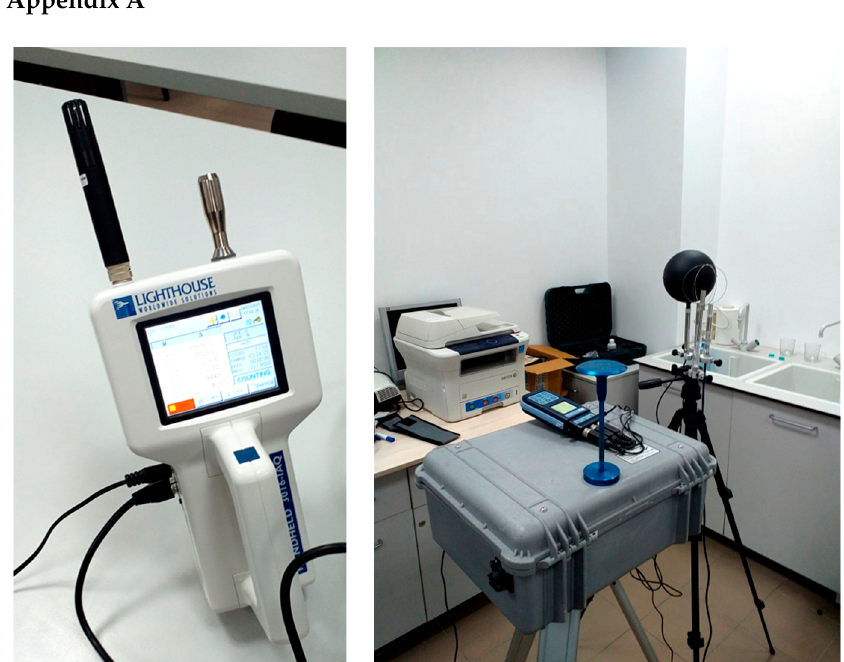
Figure A1. Instrumentation used in the current study (particle counter, PM monitor, and thermal microclimate equipment).